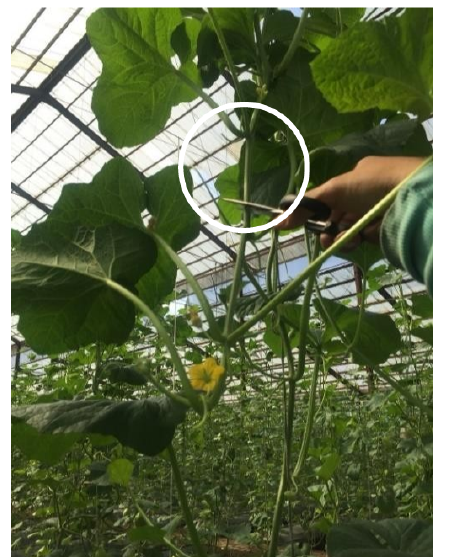
Figure 1 Trimming the top segment of the stem.